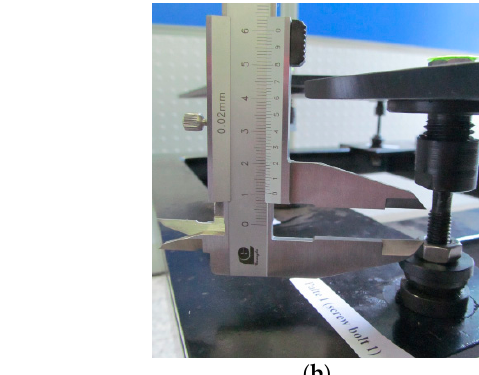
Figure 10. The fitted equation of metal plane (Plate 1 and 2) before and after the adjustment using the three ‐ rotation alignment method: ( a , b ) before adjustment, ( c , d ) after adjustment.